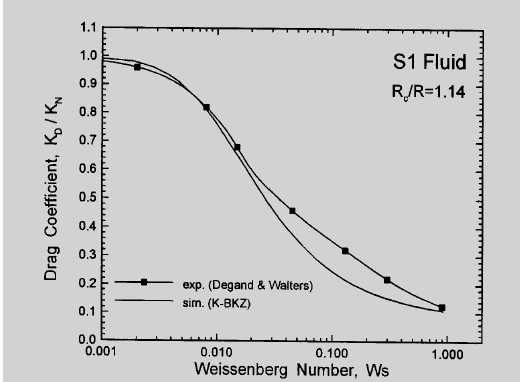
Figure 4 (left): Streamline patterns at Ws = 4 (see Eq. 7) for the flow of the S1 test fluid (polymer solution PIB/PB) at 21 ° C through a 4:1 axisym- metric contraction: (upper half) experiments [16], (lower half) simulations [17]. Figure 6: Drag coefficient vs. Weissenberg number for the shear-thinning test fluid S1 [19]. Symbols are experimental data reported by Degand and Walters [18].